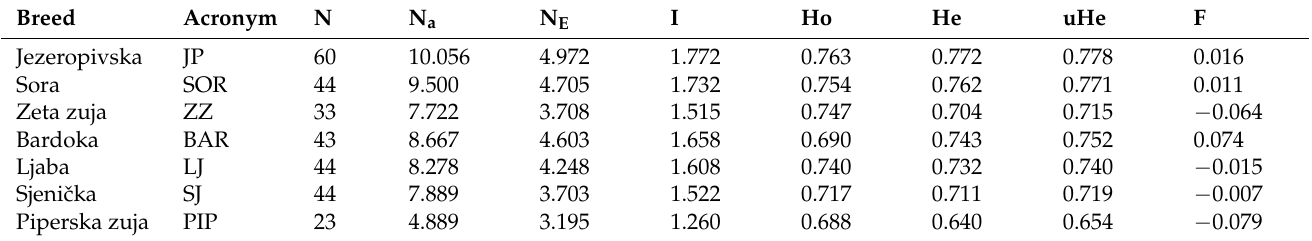
heterozygosity (uHe), and inbreeding coefficient